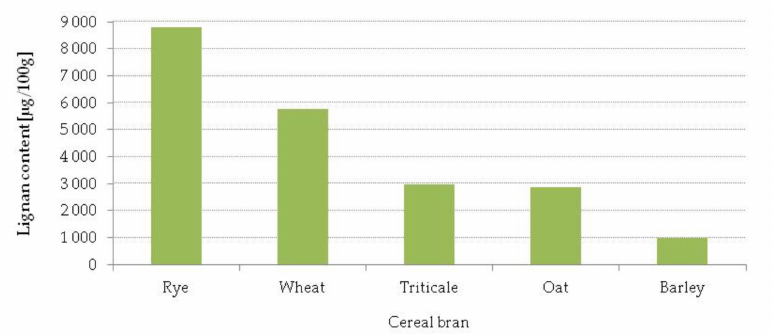
Figure 3. Lignan content in cereal bran